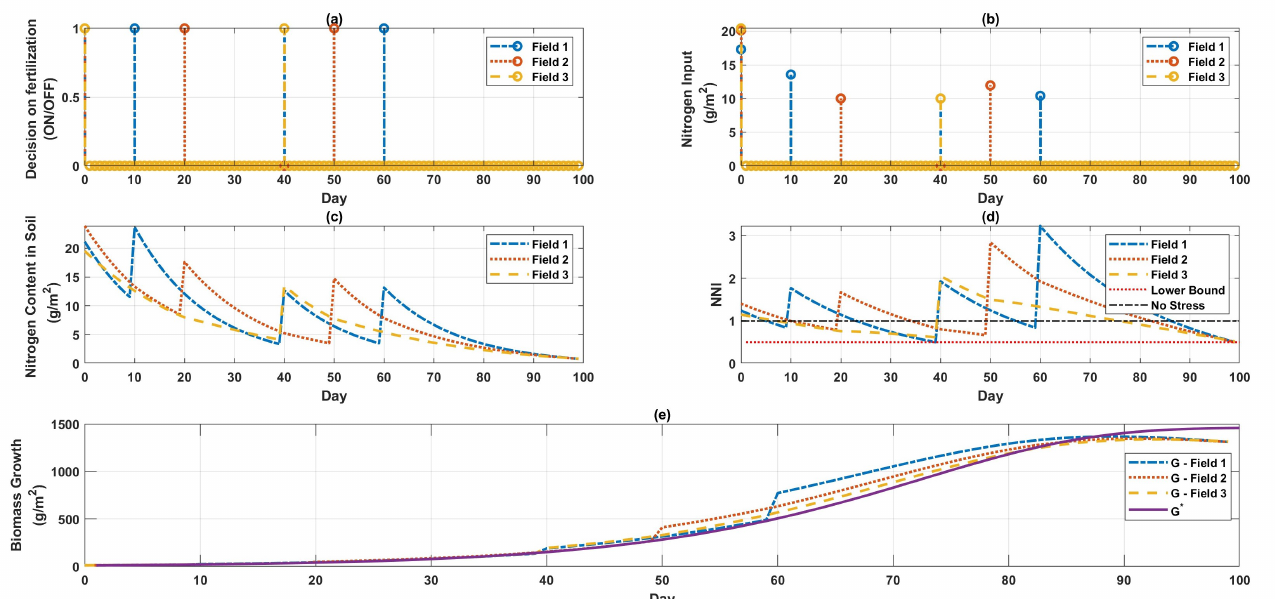
Figure 3. Maximizing the growth for multiple fields. ( a ) Indicates the days when fertilizer delivery is ON for the three fields, ( b ) displays how much fertilizer is required on these days in the three fields, ( c ) represents the nitrogen concentration of the soil within the three fields, ( d ) the NNI level, and ( e ) the progressive development of biomass in the three fields.